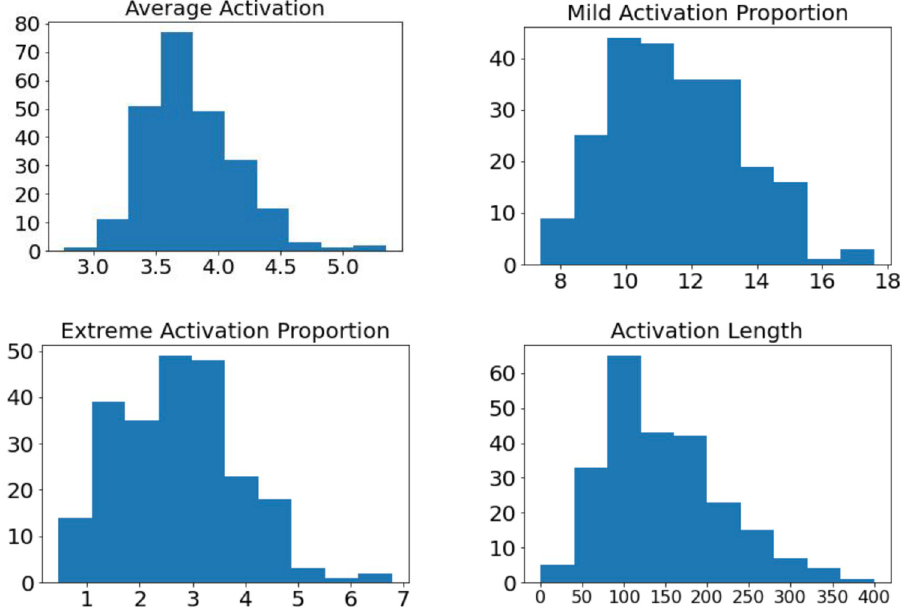
Fig 1. Histograms of four PP activation metrics. The y-axis represents the number of trader-days and the x-axis represents the activation metric values. We observe considerable variations in PP activation levels across traders. Average activation is a dimensionless quantity. Mild and extreme activation proportions are measured in percentages (%). Activation length is measured in seconds (s).